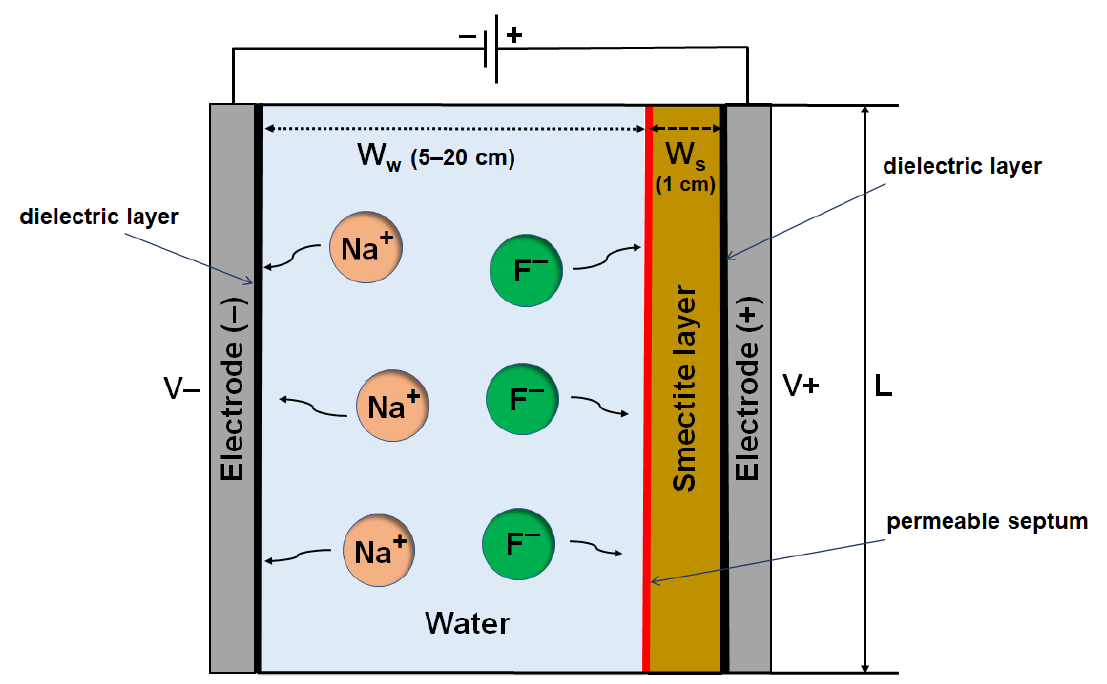
Figure 1. Top view schematic representation of the simulated device.